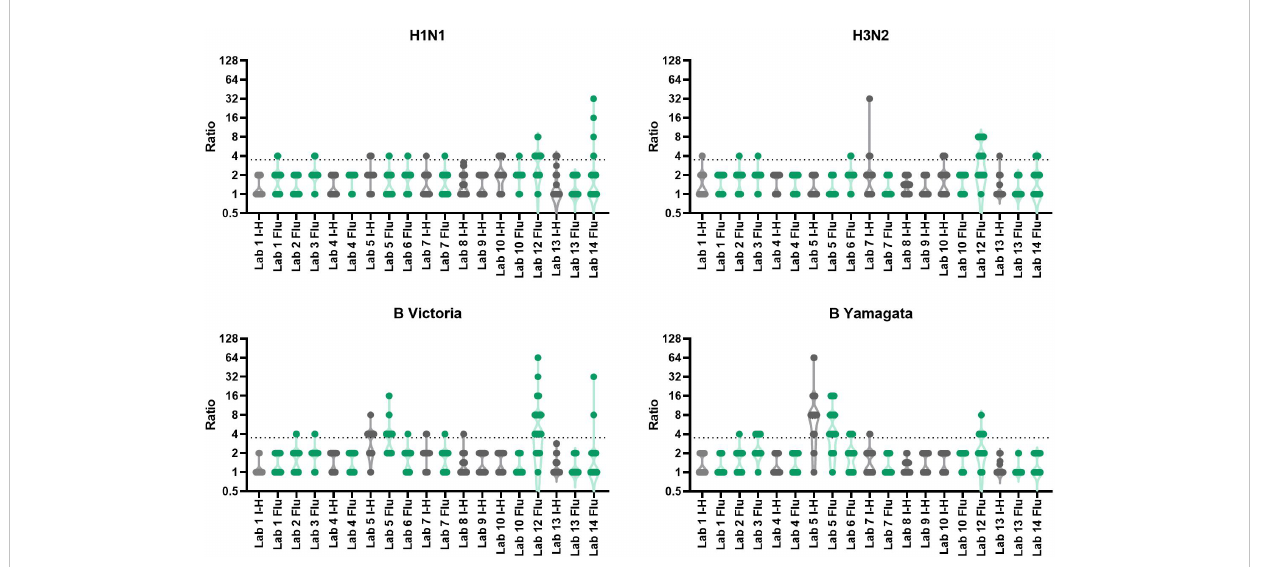
FIGURE 1 Intra-laboratory variability in HAI testing. Maximum to minimum titre ratios for three independent HAI replicates per laboratory (with the exception of Lab no.13 where only 2 replicate runs were returned). Dashed line represents the 3.5 cut-off for data exclusion for inter-laboratory variation analysis. Data in grey indicates in-house assays, data in green indicates FLUCOP